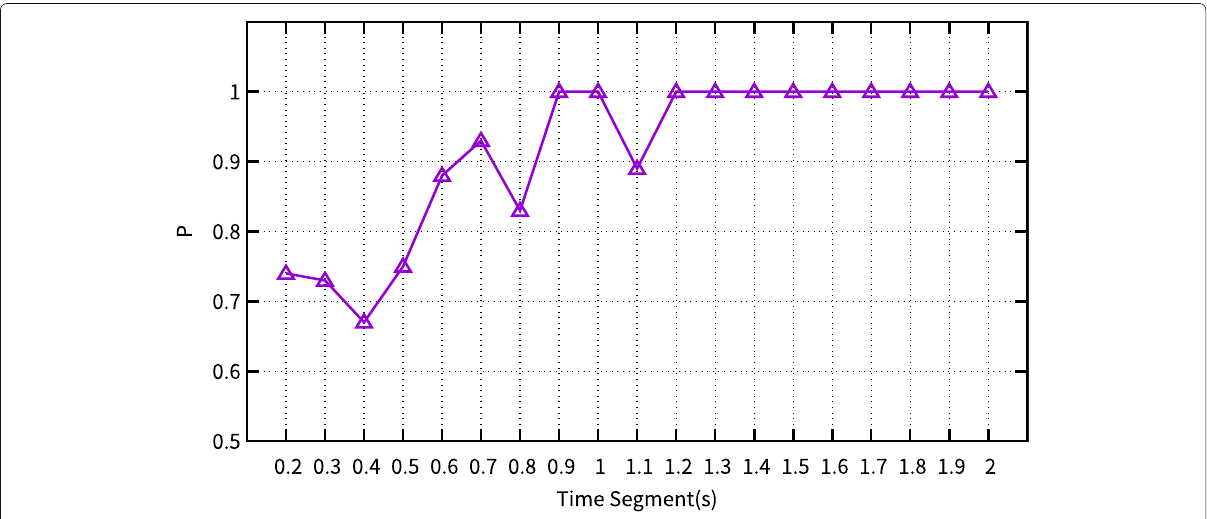
Fig. 5 Correct rate when two vehicles are traveling in the opposite direction